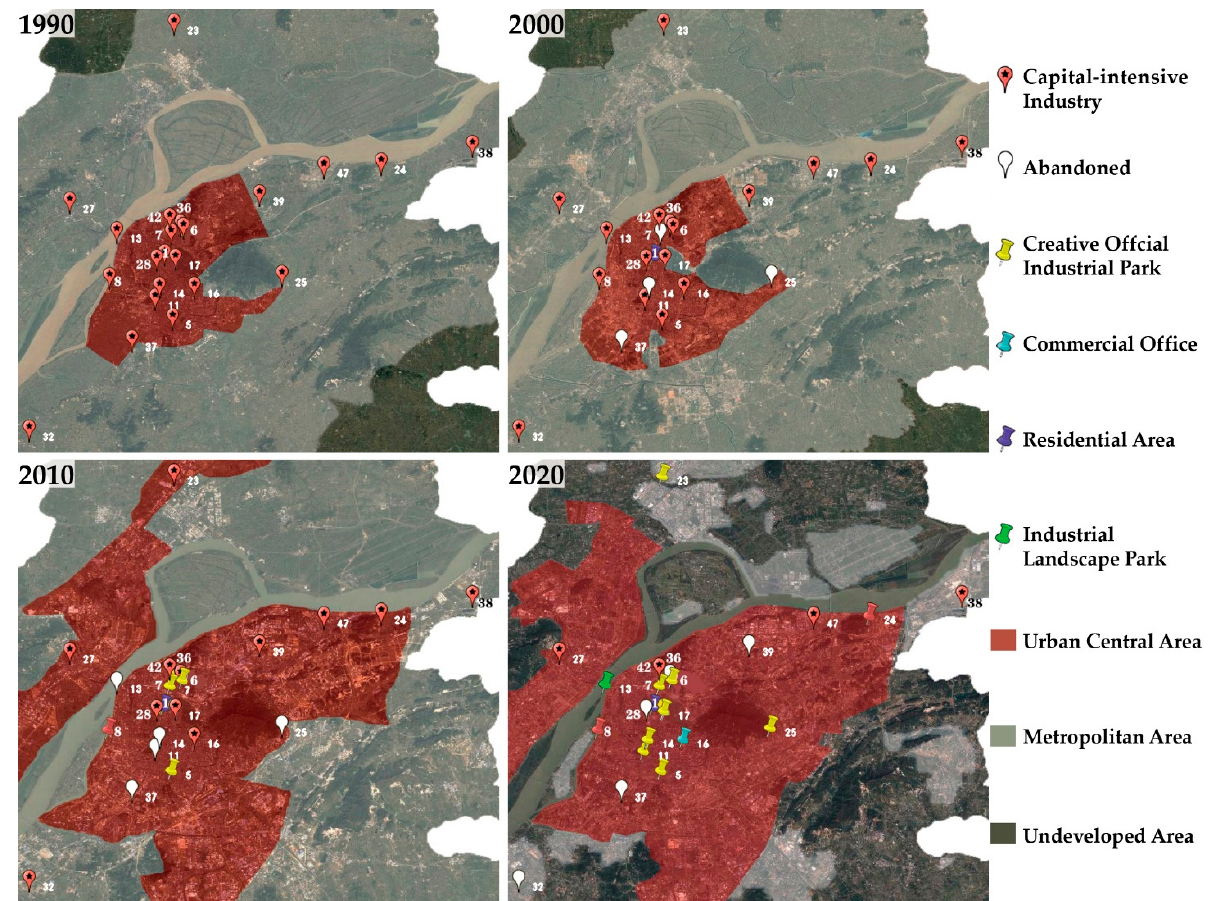
Figure 15. The change in the relationship between the operation state of capital-intensive industries and urban growth boundary over time (Figure source: own drawing; data source: on-site investigation and interview).